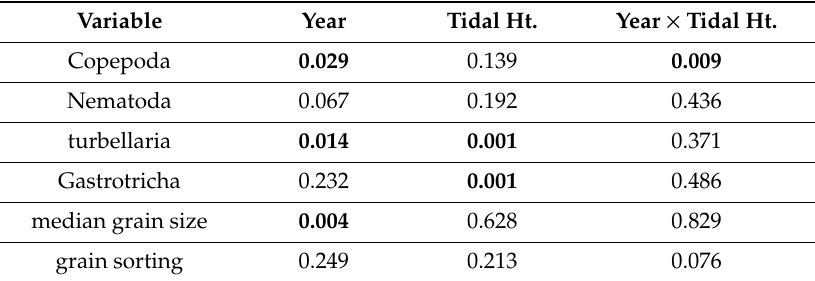
Table 2. Results of separate, 2-way (year versus tidal heights) Scheirer–Ray–Hare tests comparing faunal or granulometric variables collected in a 1969 study and a repeat of that study in 2013. Probabilities < 0.05 are in bold.